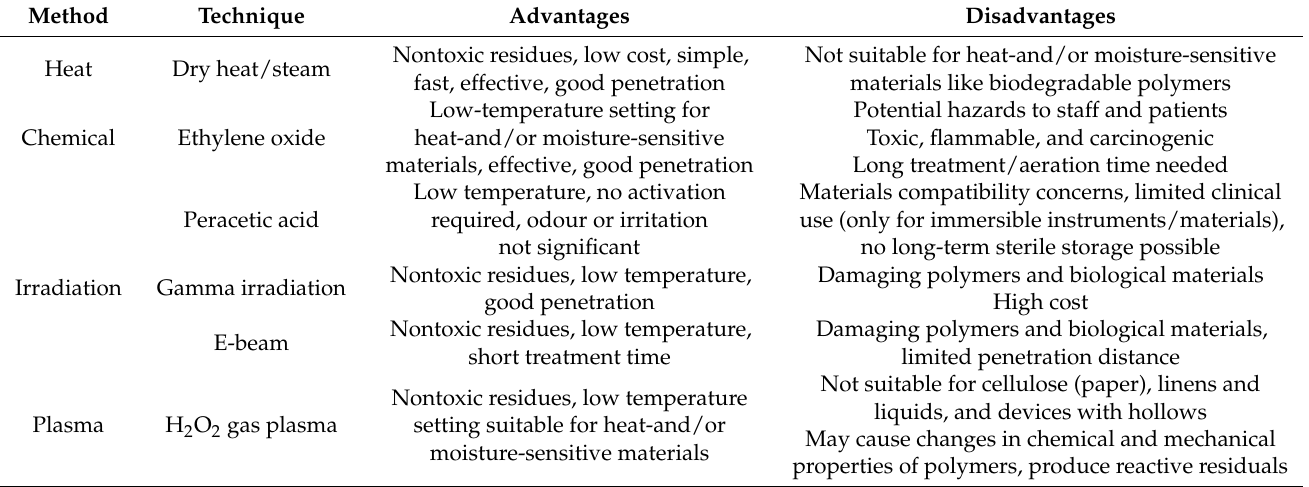
Table 1. Comparison between currently used sterilization techniques